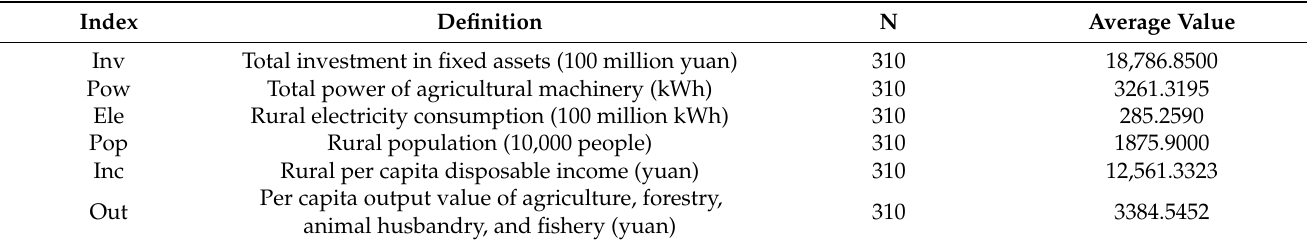
Table 7. Influencing factors of China’s agricultural economy.